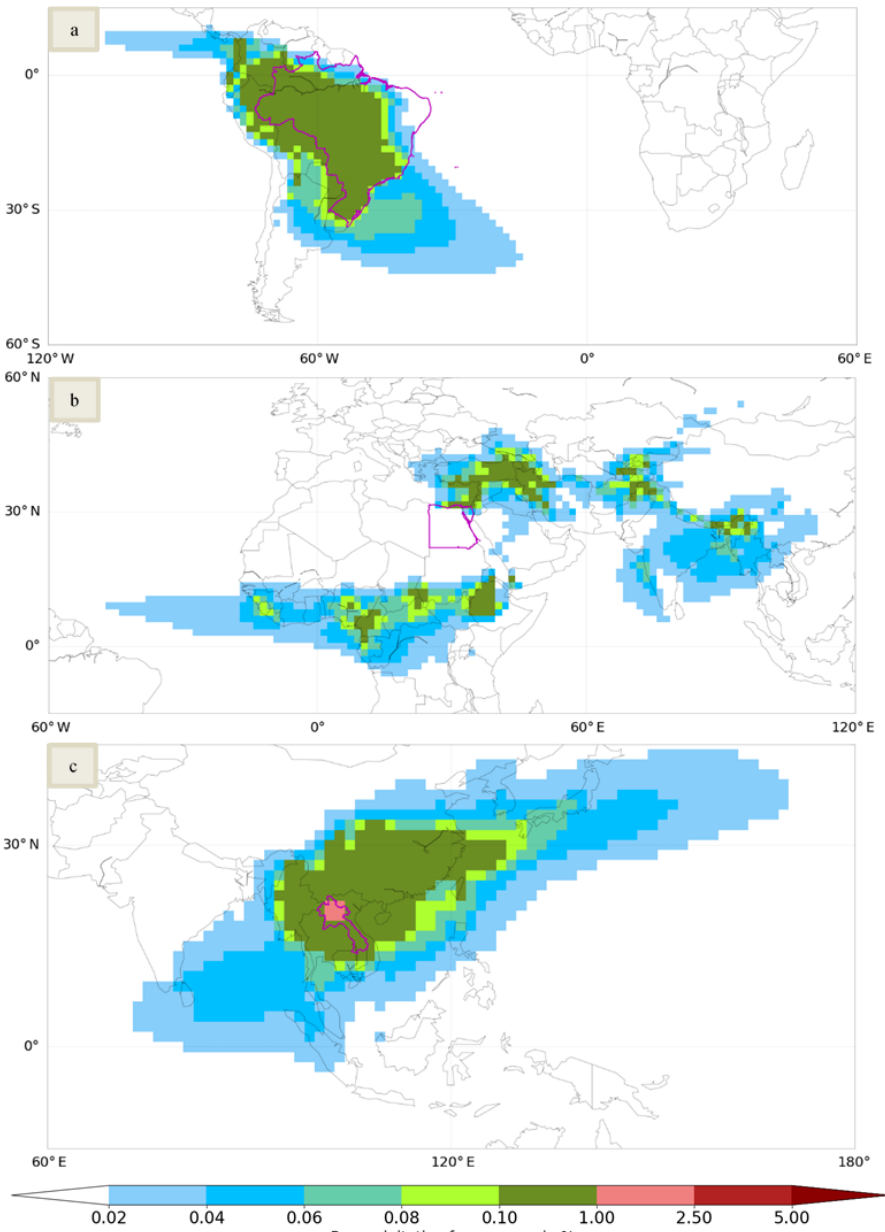
Figure 2. Examples for yearly evaporationsheds of countries. (a) Brazil ( E input : 1240.2mma − 1 ; unassigned: 0.1%): the colored area covers 80.4% of the assigned water. (b) Egypt ( E input : 104.0mma − 1 ; unassigned: 0.8%): the colored area covers 59.9% of the assigned water. (c) Laos ( E input : 1178.9mma − 1 ; unassigned: 0.4%): the colored area covers 77.9% of the assigned